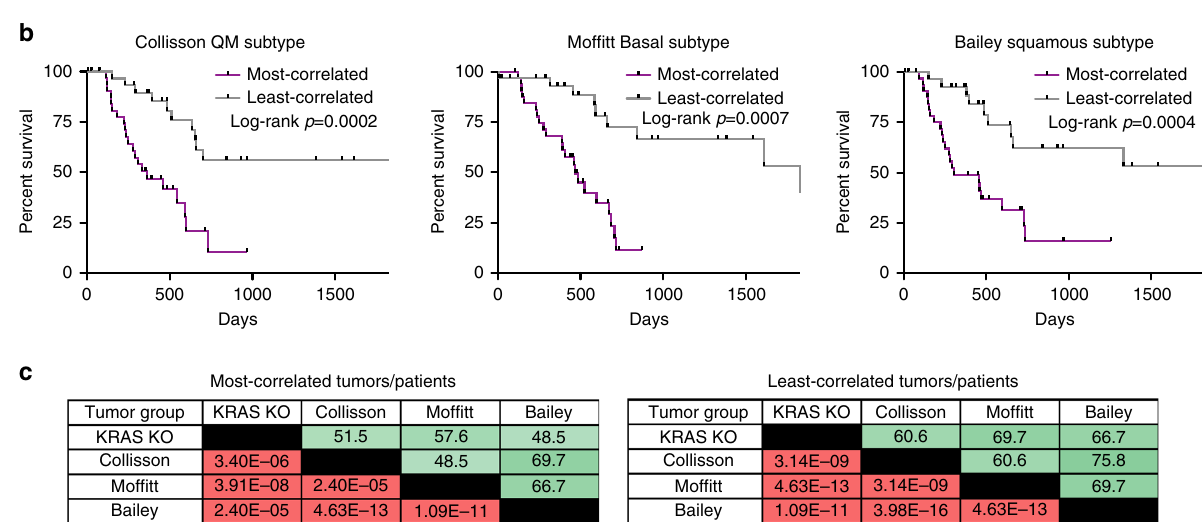
Fig. 10 KRAS knockout signature overlaps with subtype-speci fi c signatures of PDAC. a Univariate and multivariable Cox proportional hazards models on overall survival in the entire TCGA PDAC cohort, including clinical covariates and gene expression signatures, revealed that the combined KRAS knockout signature was independently associated with worse survival. Hazard ratios (HR) and p values (Cox regression) are reported. A comparison between a model with and without an interaction term (likelihood ratio test) was used to determine independence ( p > 0.05) between signi fi cant covariates in multivariable analysis and the combined KRAS knockout signature. b Kaplan – Meier plots of survival in human PDAC patients from the TCGA cohort based on tumors most correlated (top quintile) and least correlated (bottom quintile) with the quasi-mesenchymal (QM) subtype from Collisson et al. 21 , basal subtype signature from Mof fi tt et al. 46 , and the squamous subtype signature from Bailey et al. 45 ( n = 33 most correlated and n = 33 least correlated tumors). Log-rank (Mantel – Cox) p values are shown. c Tables show percentage of tumor/patient overlap of top (most correlated) and bottom (least correlated) quintiles of tumors (out of n = 33 per group) in each signature. Green shading corresponds to degree of overlap (white = 0%, dark green = 100%). p values for signi fi cance of overlap (between n = 33 groups) within the TCGA PDAC cohort (out of 166 total tumors) are also shown (hypergeometric test). Red shading corresponds to signi fi cance of overlap (white = 0.05, dark red = minimum p